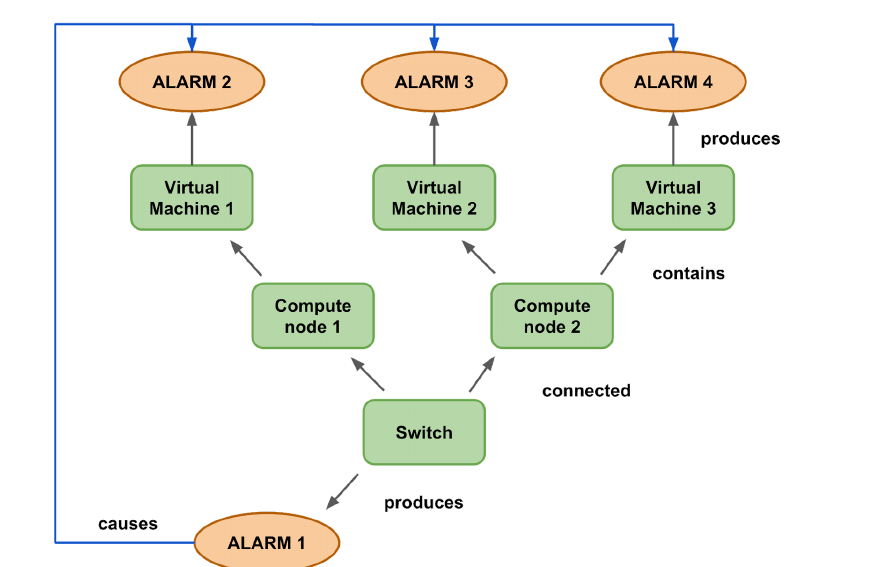
Figure 3 . The Root Cause Engine extracts the root cause among a set of ​